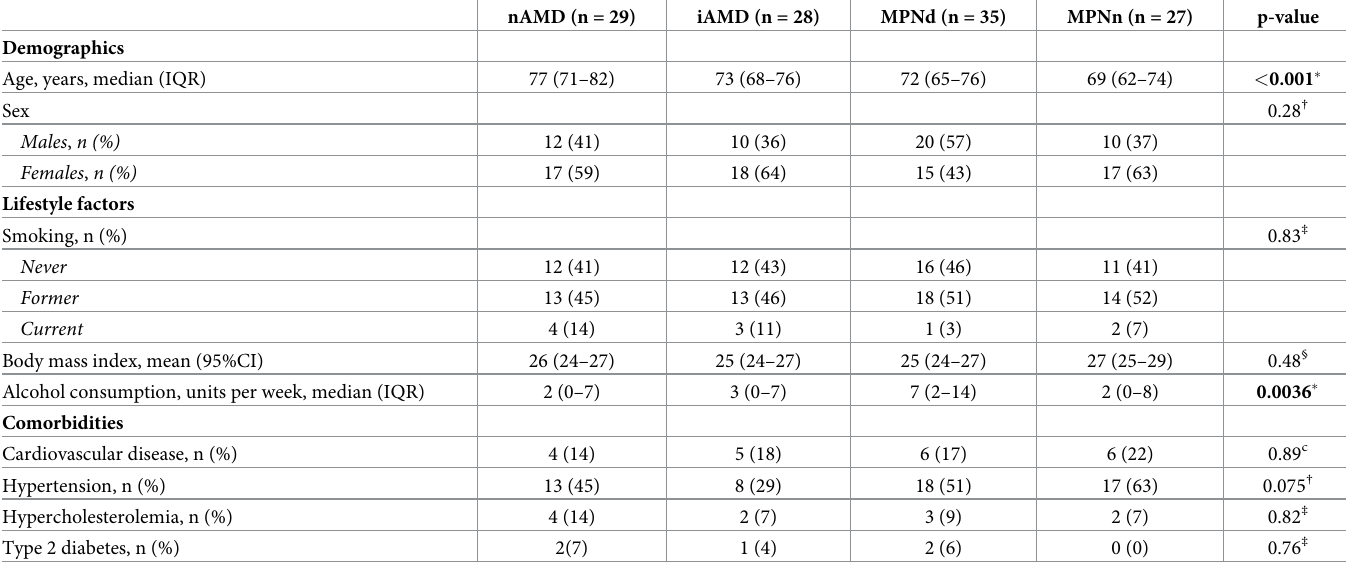
Table 1. Patient